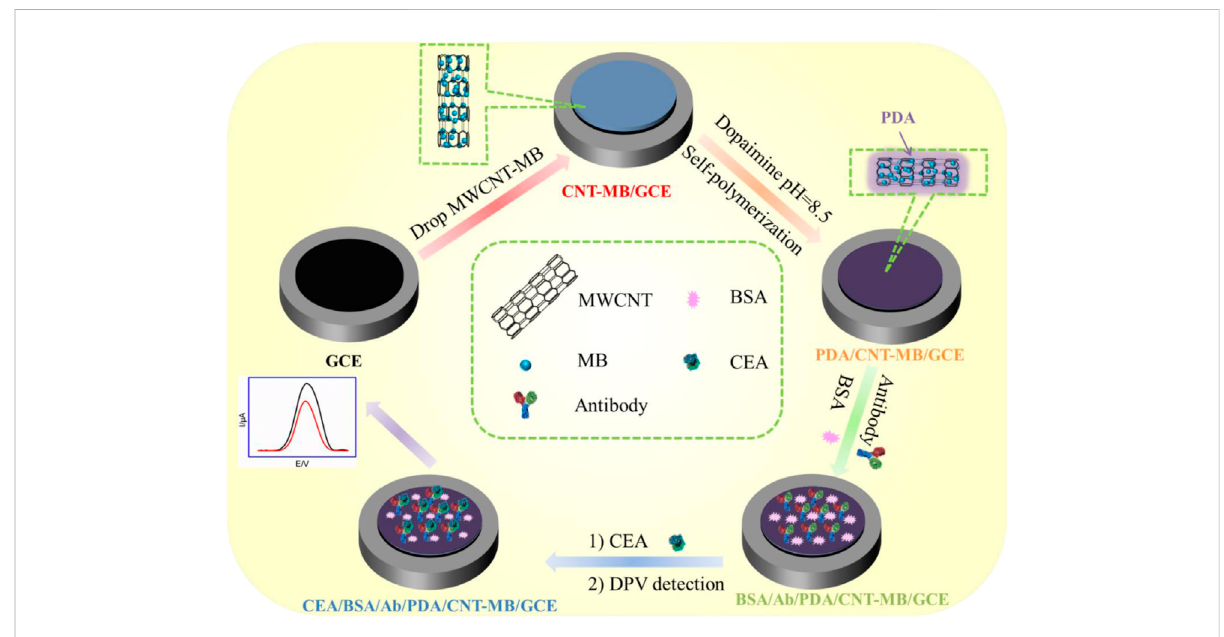
FIGURE 1 Schematic illustration for the fabrication of immunoanalysis interface and the following label-free electrochemical determination of CEA.